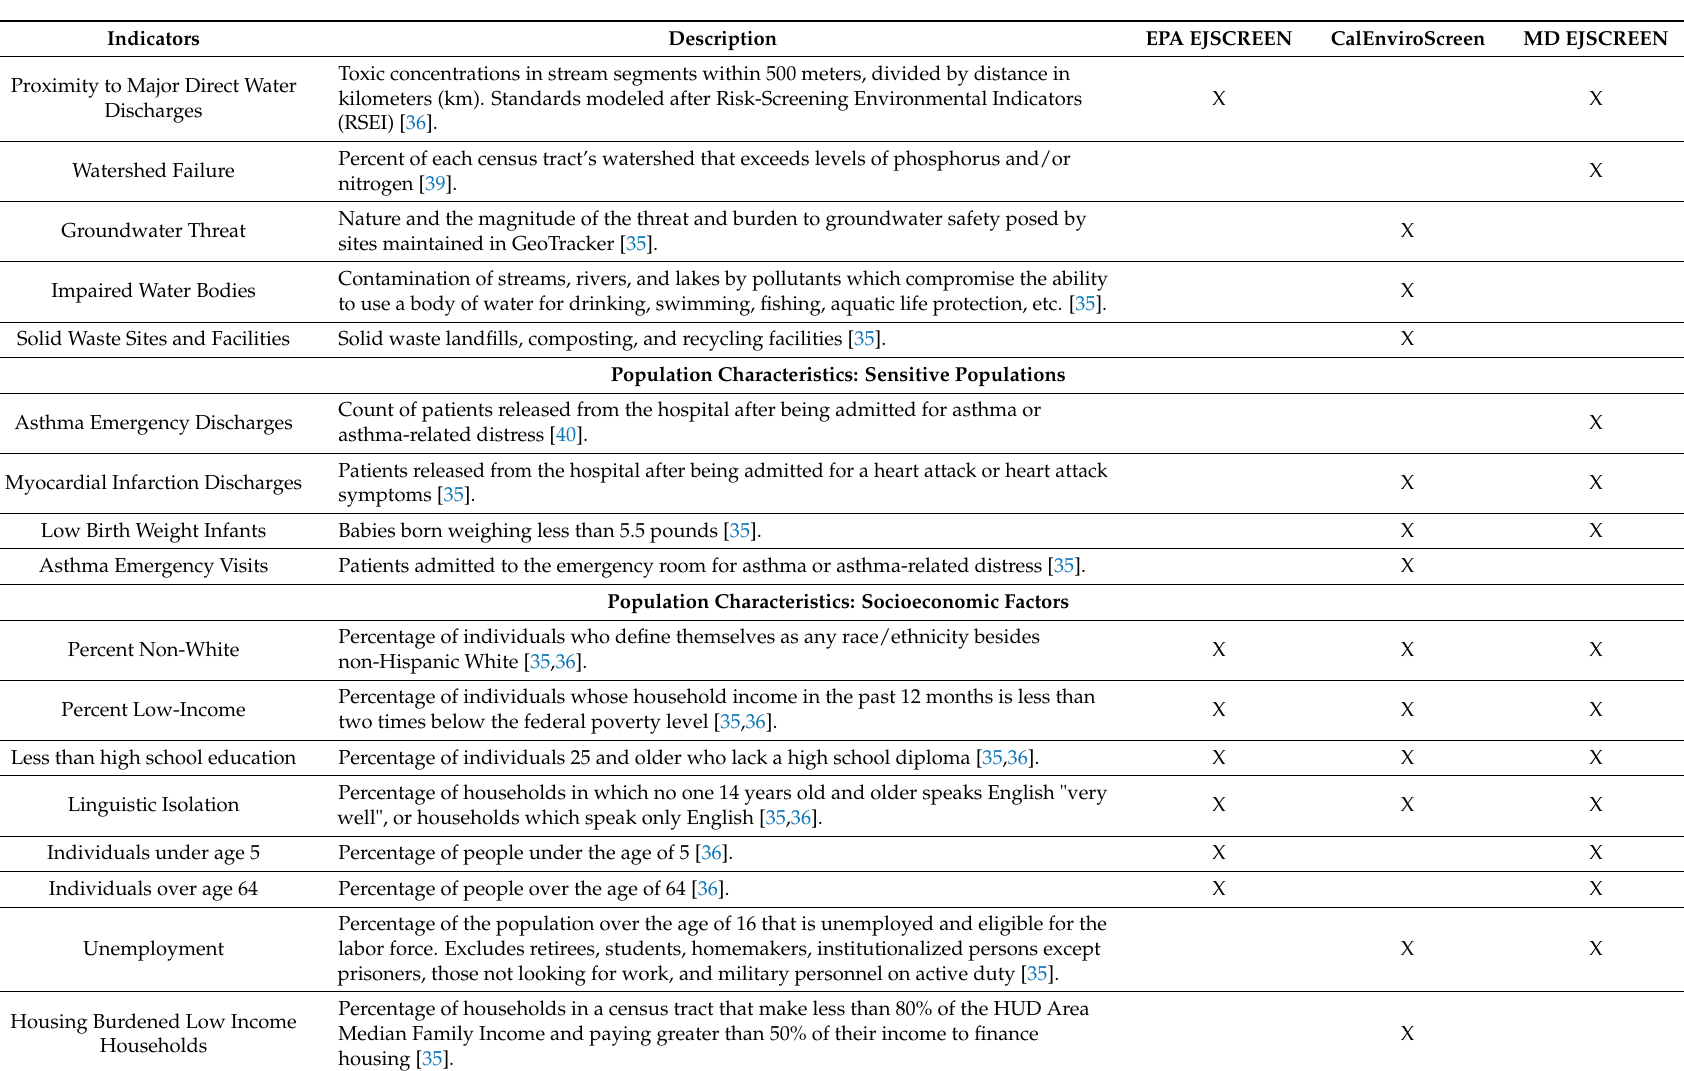
Population Characteristics: Sensitive